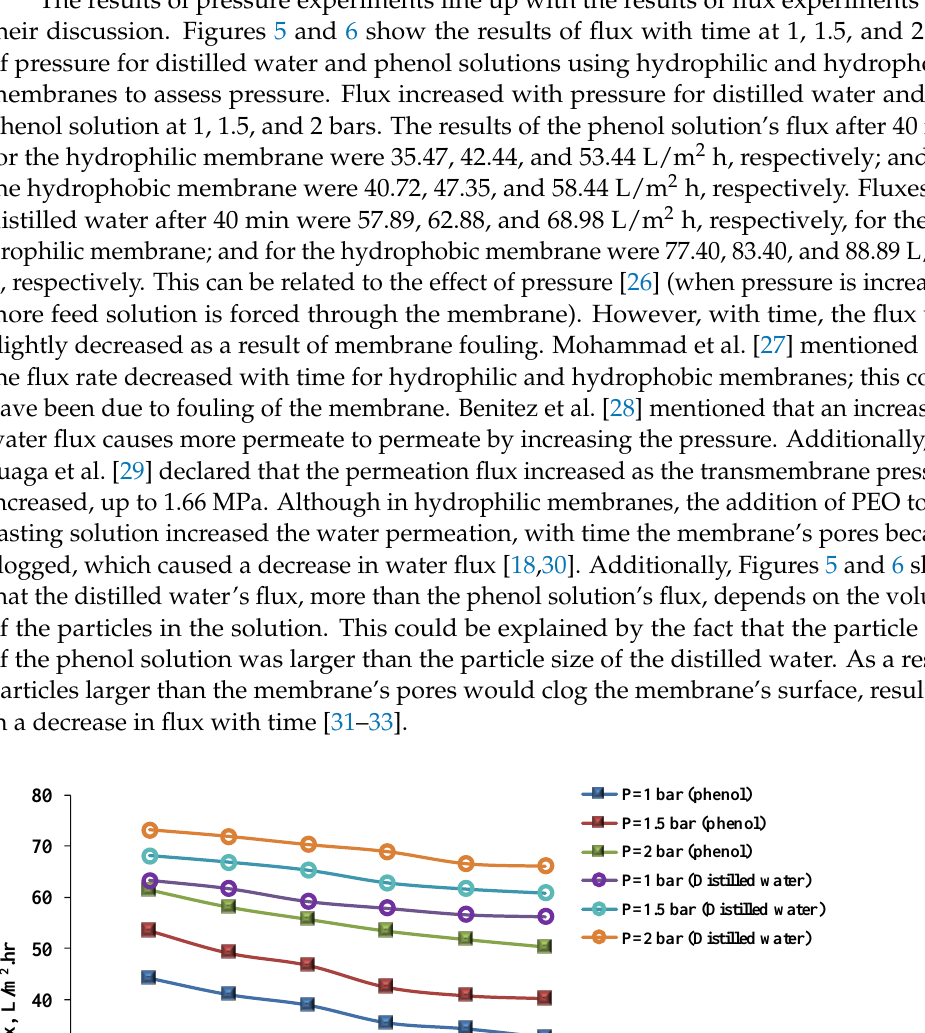
Figure 6. Phenol solution and distilled water’s fluxes with time for a hydrophilic membrane at dif- ferent pressures (phenol concentration = 50 mg/L, temperature = 30 °C). 3.3. Effect of Concentration To illustrate, the water flux decreased over time as the phenol solution’s concentra- tion increased from 10 to 80 mg/L when hydrophilic and then hydrophobic membranes were used. Figures 7 and 8 show that the fluxes at phenol solution concentrations of 10, 50, and 80 mg/L were 39.66, 35.47, and 28.38 L/m 2 h, respectively, for the hydrophilic mem- brane. For the hydrophobic membrane, the fluxes were 47.47, 40.72, and 34.38 L/m 2 h, re- spectively, after 40 min. The cause of these results was the increase in phenol concentra- tion. The particles in the solution increased and caused the pores to clog. Additionally, if the particle concentration in the solution is high, the particles will be accumulated on the membrane surface, and when phenol concentration is increased [30], the number of par- ticles is increased, forming a thin layer on the membrane and preventing the phenol solu- tion from permeating, but such a drop was not observed with a flux of distilled water [33,36]. The previous findings may be consistent with those of Benosmane et al. [21], who